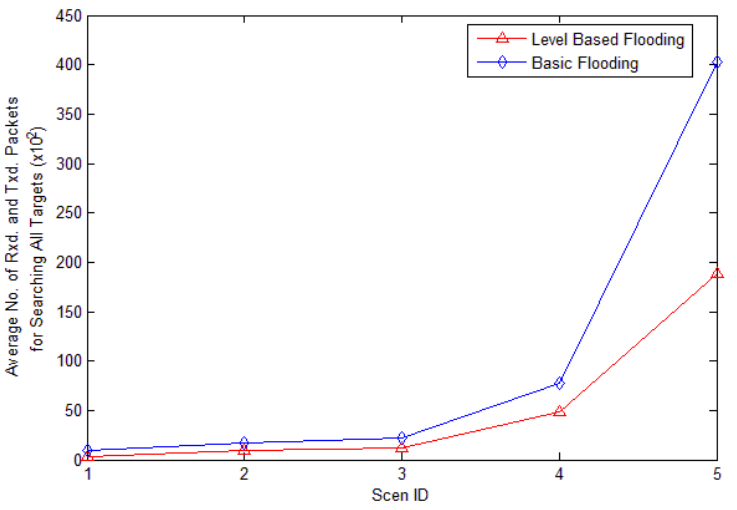
Figure 25. Average energy cost for finding all targets.